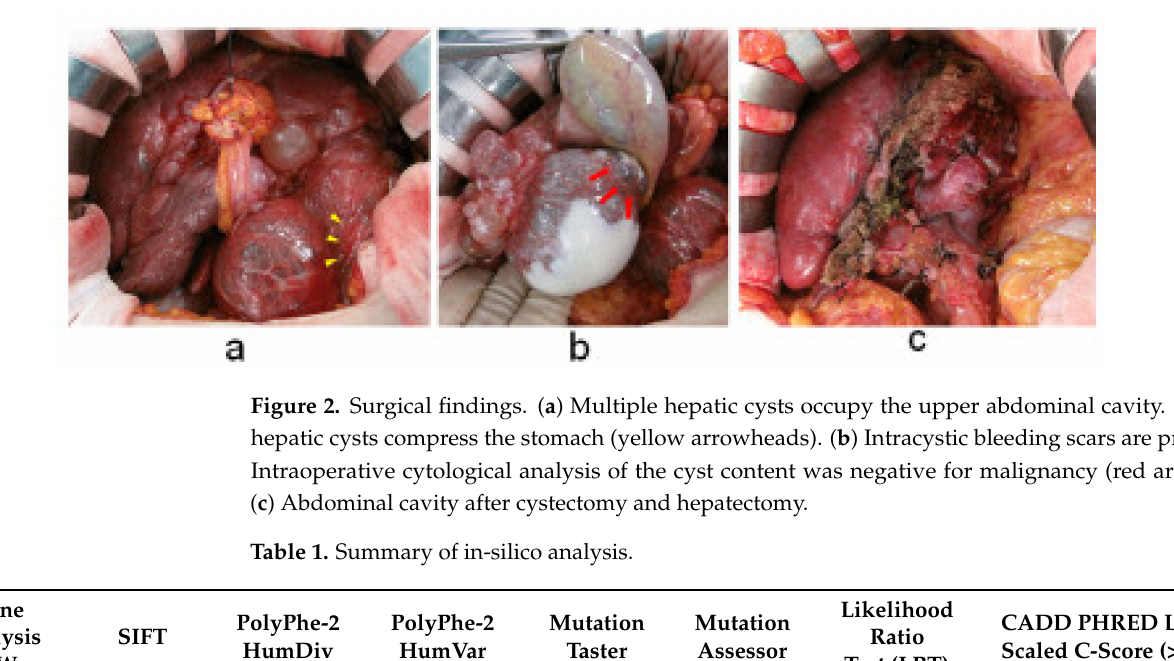
Figure 1. Magnetic resonance imaging of the polycystic liver performed during the patient’s first visit. ( a ) Axial T2-weighted image. ( b ) Magnetic resonance cholangiopancreatography revealed intracystic heterogeneity and septation with associated focal hyperintensity, suggestive of intracystic bleeding (red arrows). Extrahepatic cysts compress the stomach (yellow arrowheads).